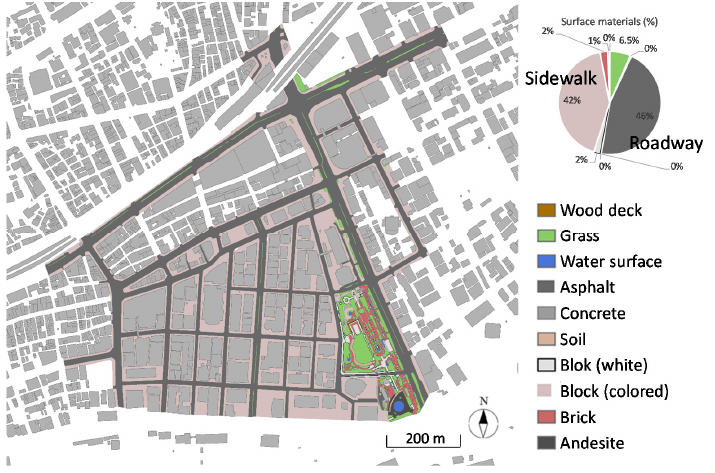
Figure 4. Building shape (gray—top view) and land cover distribution in the objective area.